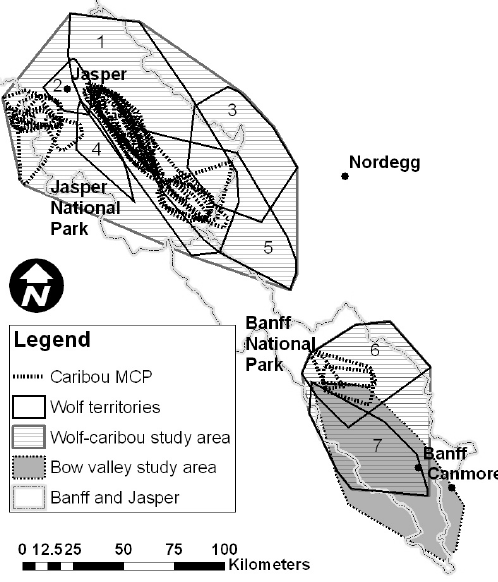
Fig. 2. Study area location in western Canada (see inset) showing annual winter home ranges for caribou (dashed) and multi-annual winter wolf territories (solid), respectively, from 2003 - 2004 in Banff National Park (Banff) and southern Jasper National Park (Jasper), Alberta, Canada. Cross-hatched areas are the Banff and Jasper wolf-caribou study areas used to estimate densities, and the shaded area is the Bow Valley study area in which wolf and elk densities were recorded from 1985 to 2003 to estimate the numeric response (see text). Numbers represent wolf packs; 1) Maligne, 2) Signal (town), 3) Brazeau, 4) Sunwapta, 5) Medicine, 6) Red Deer, and 7) Bow